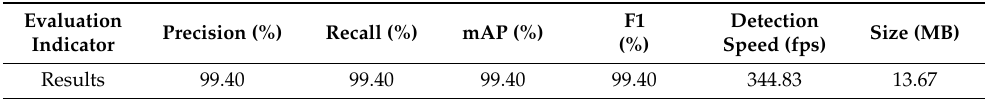
Table 3. Detection results of grape